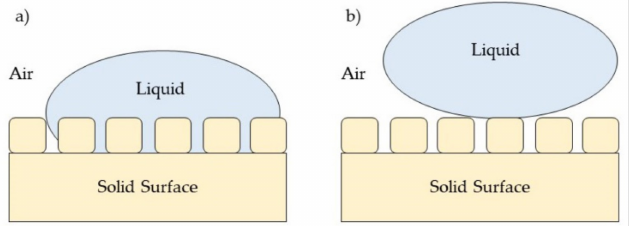
Figure 10. Wetting of liquid droplets on rough surfaces. ( a ) Wenzel model and ( b ) Cassie–Baxter